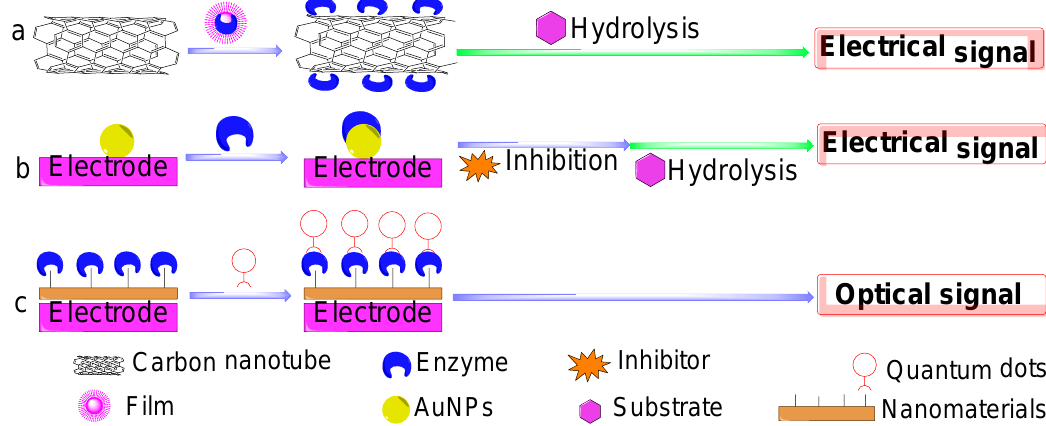
Figure 6. Schematic diagram of nanomaterial-based biosensors: ( a ) carbon nanotubes-based biosensor ( b ) Au nanoparticle-based electrochemical sensor ( c ) Quantum dots-based biosensor.